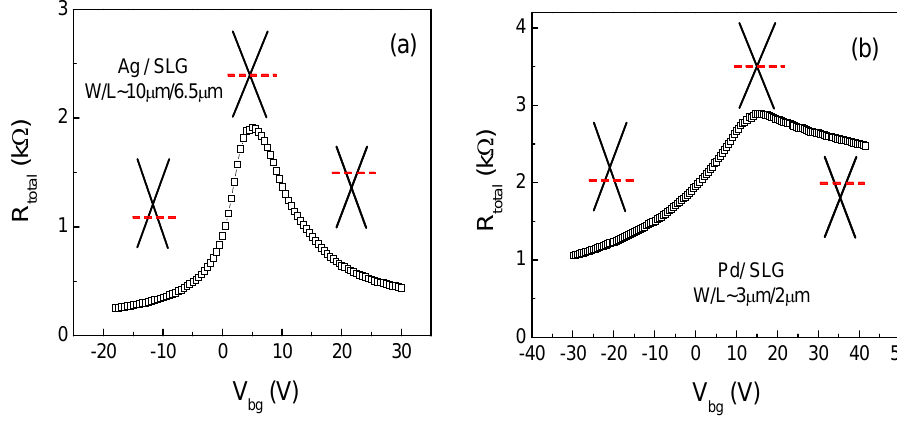
− V plots of SLG FETs with various metal electrodes ( a ) Ag; ( b ) Pd; Figure 7. R odd bg ( c ) Al, respectively. Insets show the Fermi level (red dash) with respect to the Dirac point at the hole and electron transportation regions; ( d ) R vs. ( V − V ) plots with various odd bg Dirac electrodes. All R vs. ( V − V ) curves show the asymmetry in hole and electron total bg Dirac is positive for Ag, Ti, Au, Pd–graphene devices, and negative transportation regions. R odd for Al/SLG